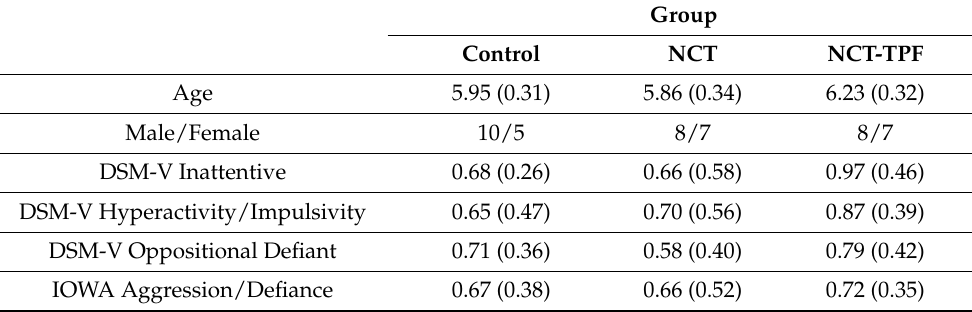
Table 1. Age, sex, DSM-V, IOWA and Conners scores for each group at pre-training